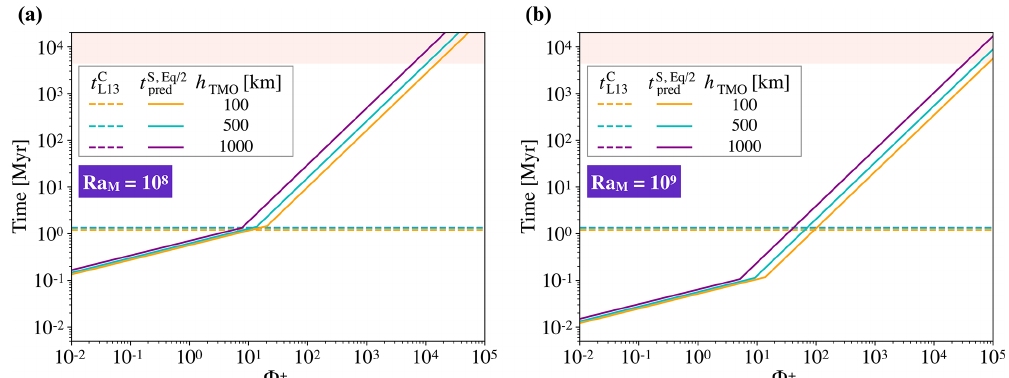
Figure 7. Timescales to reach chemical half-equilibrium between the solid mantle and a TMO of 100, 500, and 1000km (orange, blue, and purple solid lines respectively; this study, t S, Eq/2 ) versus different values of phase change number, (cid:56) + , and timescales of crystallisation pred of that TMO until it is completely mushy (thicknesses are shown using the same colours and dashed lines, from Lebrun et al., 2013, t C versus different values of phase change number, (cid:56) + . Panel (a) corresponds to a Rayleigh number of the solid part of Ra M = 10 8 , and panel (b) corresponds to Ra M = 10 9 . The rose shading corresponds to a time higher than the age of the Earth. We note that t C consistent with the timescales constrained by Nikolaou et al. (2019) and Salvador et al.